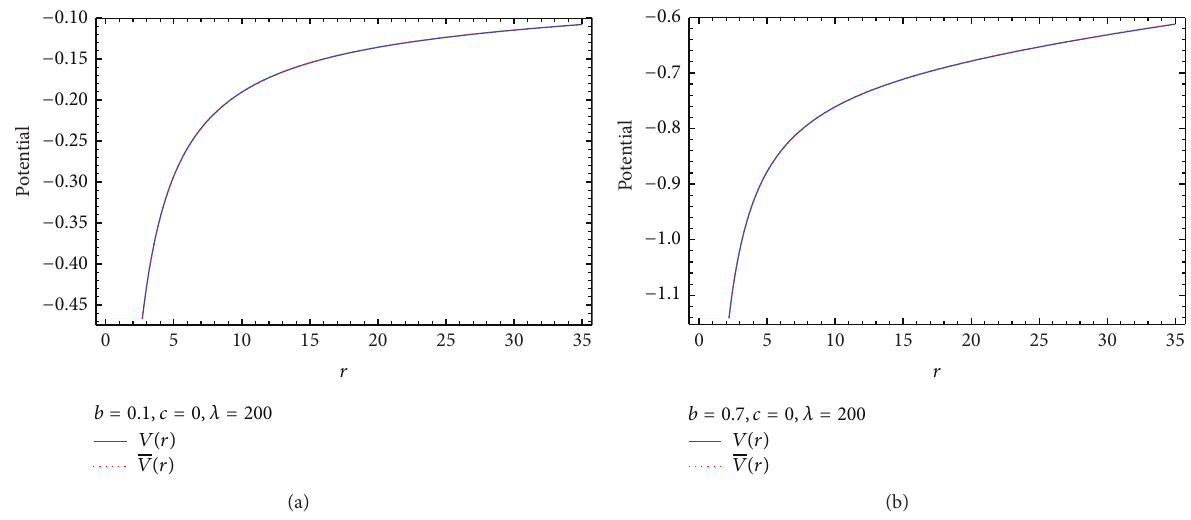
Figure 3: (a) Comparison of 𝑉(𝑟) and 𝑉(𝑟) potentials in case of 𝑏 = 0.1 , 𝑐 = 0 , and 𝜆 = 200 (in arbitrary units). (b) Comparison of 𝑉(𝑟) and 𝑉(𝑟) potentials in case of 𝑏 = 0.7 , 𝑐 = 0 , and 𝜆 = 200 (in arbitrary units).